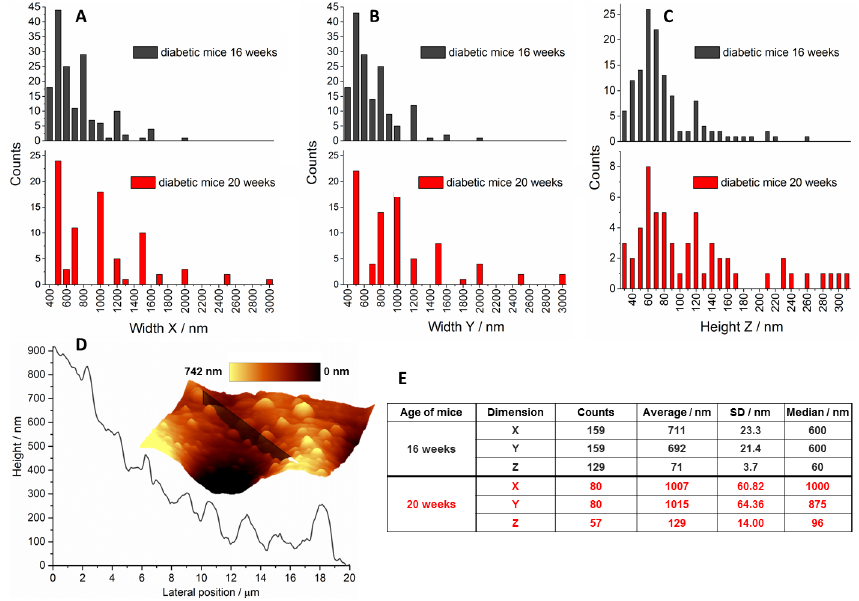
Figure 5. Size statistics of clustered lipid rafts in T2DM. The x ( A ), y ( B ) and z ( C ) dimensions of LRs observed for 16-weeks-old (black) and 20- weeks-old (red) mice determined based on the acquired AFM topography images (the example in D : a representative topography image along with a topography cross-section) and the summary of statistical data related to the LRs size ( E ).